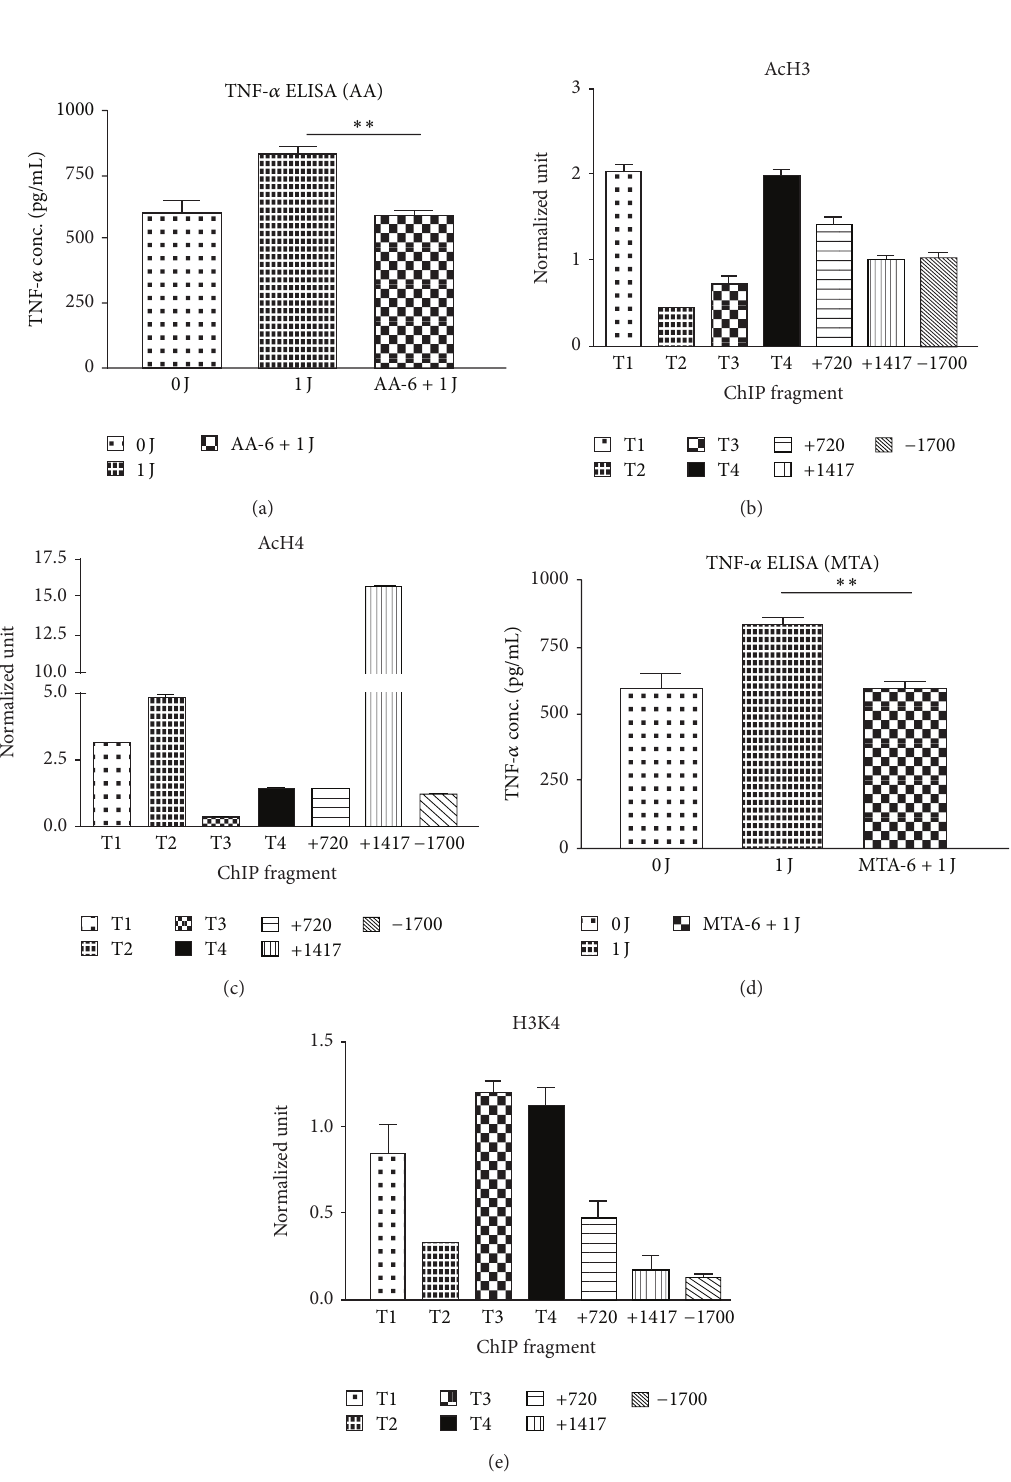
Figure 6: The involvement of histone acetylation and methylation in the regulatory effect of LLLT on TNF- 𝛼 expression. The levels of TNF- 𝛼 expression in LLLT-treated THP-1 cells in the presence or absence of AA (a) and MTA (d) using ELISA assay. ChIP analysis of the relative levels of acetylated H3 (AcH3) (b), acetylated H4 (AcH4) (c), and trimethylated H3K4 (e) at the TNF- 𝛼 gene locus. ChIP encompassed the following subregions relative to the transcription start site: TNF1 (T1, +99 to –42), TNF2 (T2, +32 to –119), TNF3 (T3, –100 to –250), TNF4 (T4, –195 to –345), +1417, +720, and –1700. The relative levels were normalized to the input DNA and shown as the means ( ± SD) of 3 individual study subjects. ∗∗ 𝑃 < 0.01 was considered significant compared with the control without